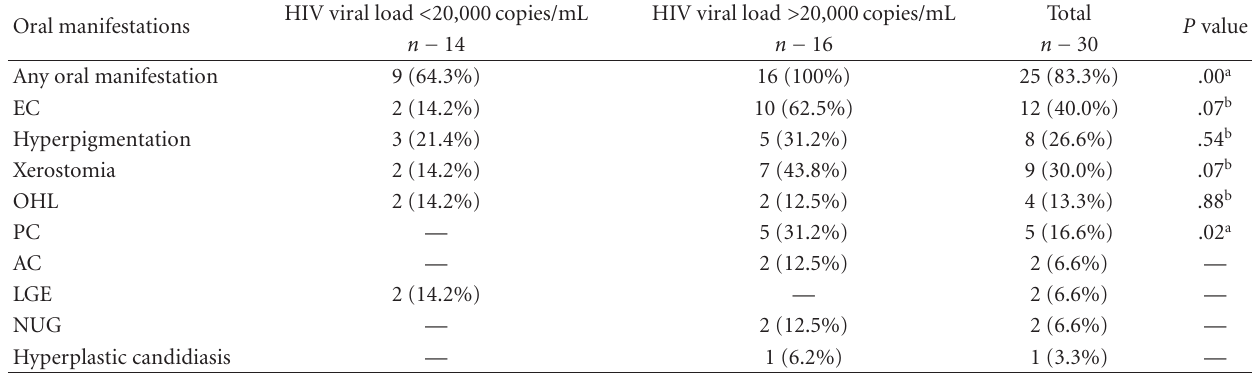
Table 6: Comparison of oral manifestations with respect to HIV viral load subpopulation.